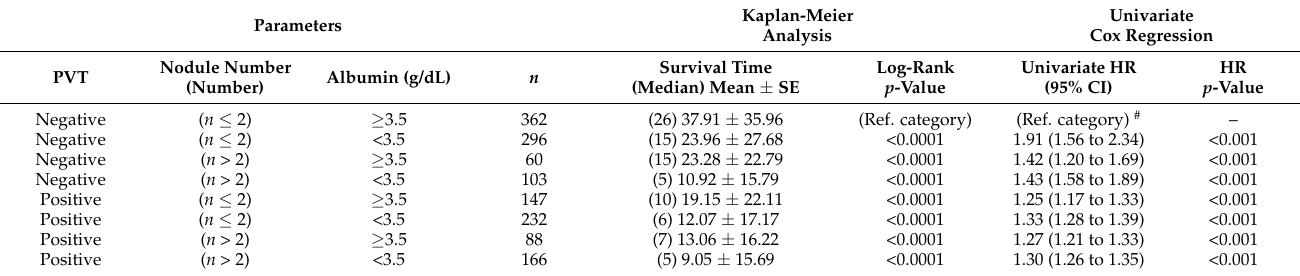
These three parameters were then combined in all eight possible combinations, and each combination was examined in relation to patient survival time using both Kaplan– Meier analysis and univariate Cox regression analysis (Table 2). Table 2. Kaplan–Meier analysis and Cox regression for PVT and multifocality and albumin combinations in HCC patients.